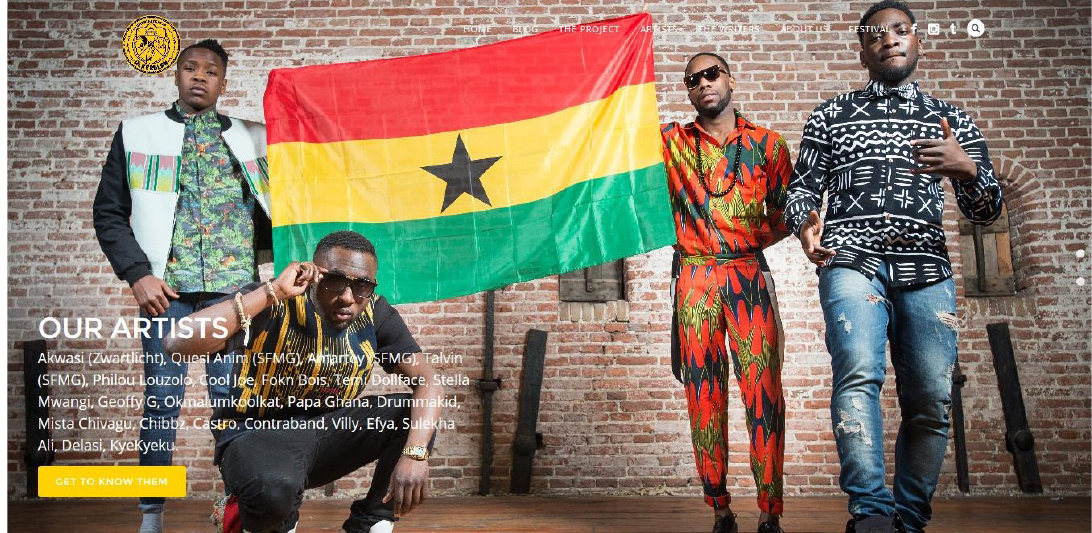
Figure 2. ‘Our artists’ page from Alkebulan website,